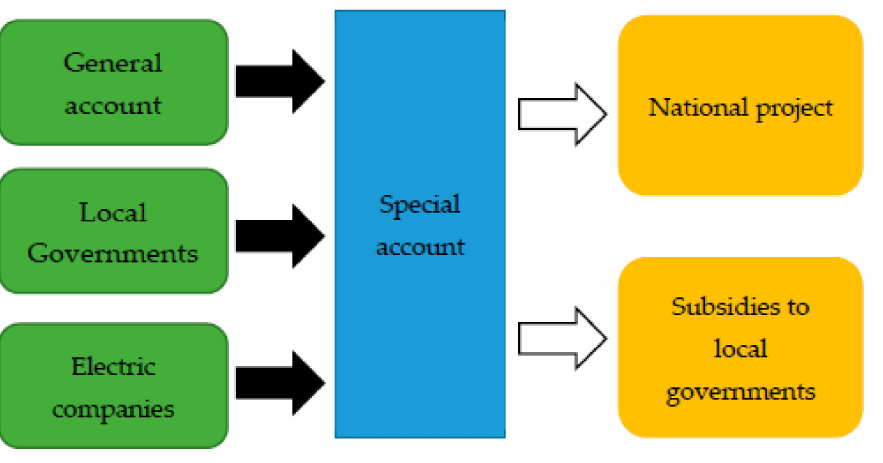
Figure 7. Mechanism of special account for flood protection. Source: Authors’